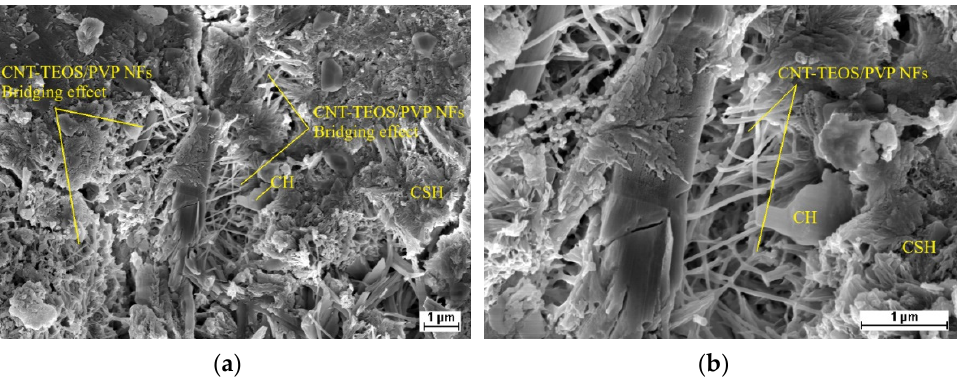
Figure 9. SEM images of cement matrix containing CNT-TEOS/PVP NFs. ( a ) magnification of 20 k, ( b ) magnification of 50 k. ( b ) magnification of 50 k. ( b ) magnification of 50